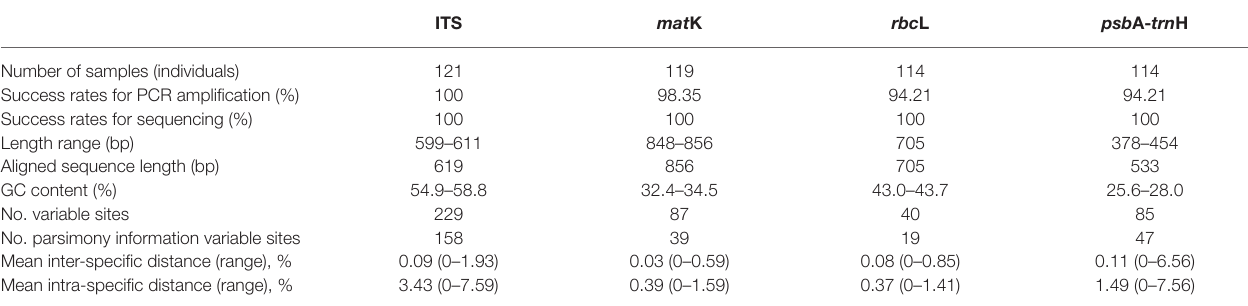
TABLE 1 | Success rates for PCR amplification and sequencing, and sequence characteristics of each single candidate barcodes.